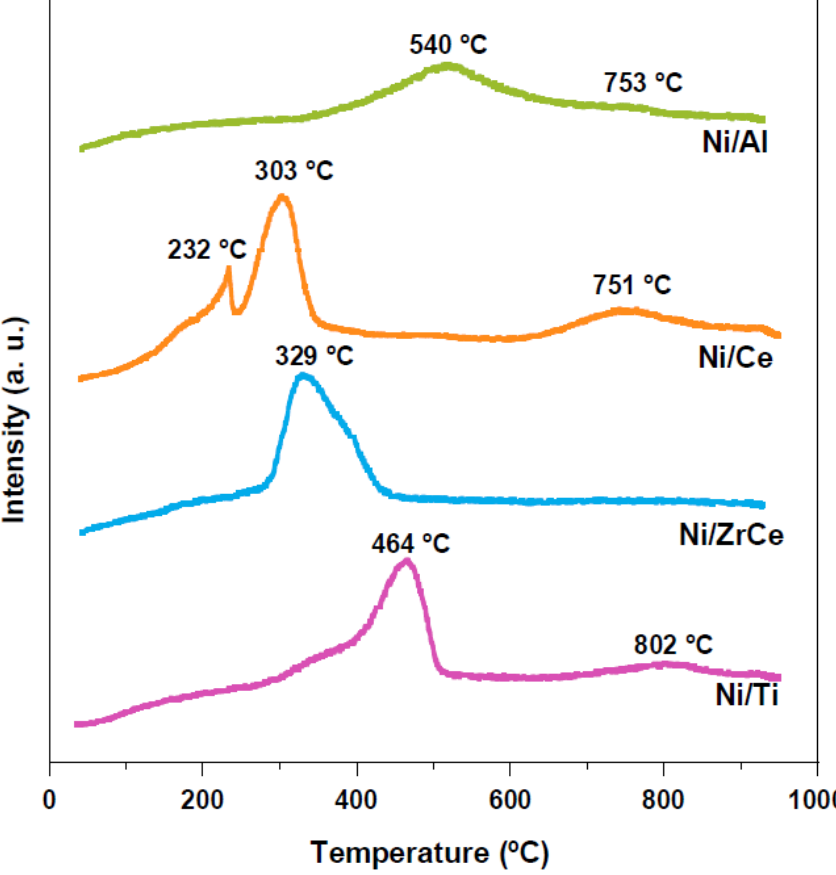
Figure 2. H 2 -TPR profiles of the calcined supported nickel catalysts.